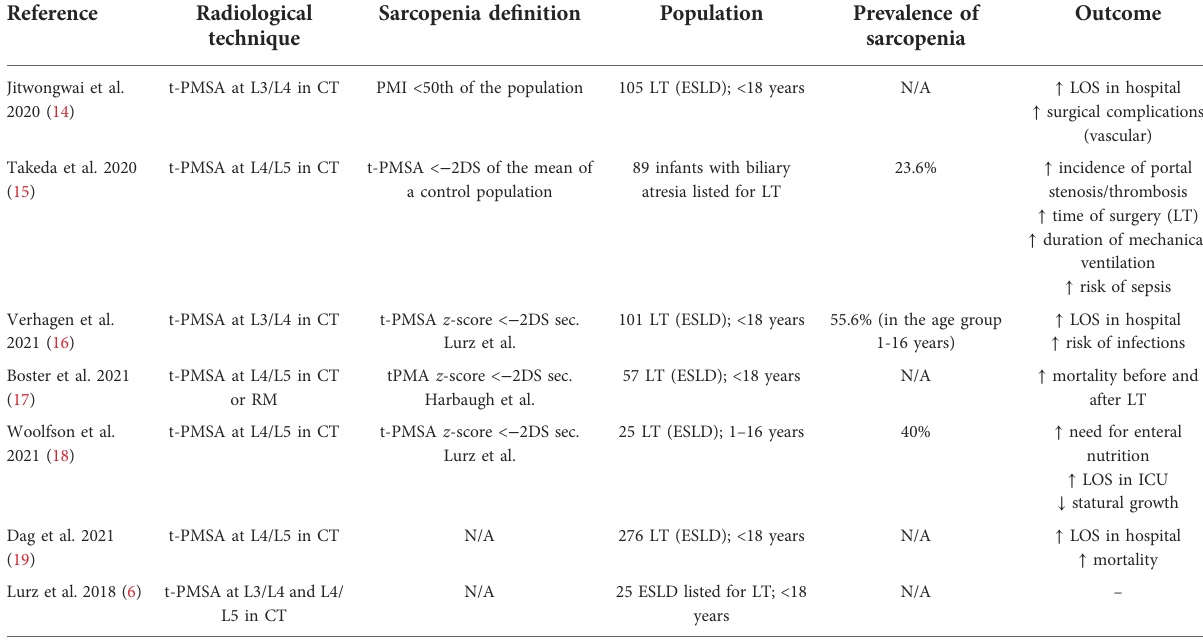
TABLE 5 Pediatric studies on sarcopenia in children with end stage liver